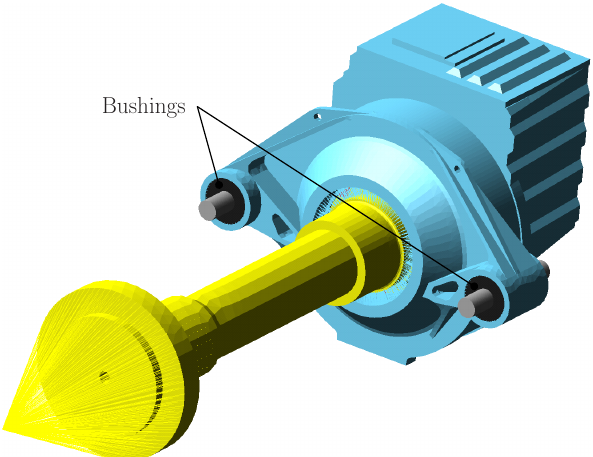
Figure 3: Bushings mounted in